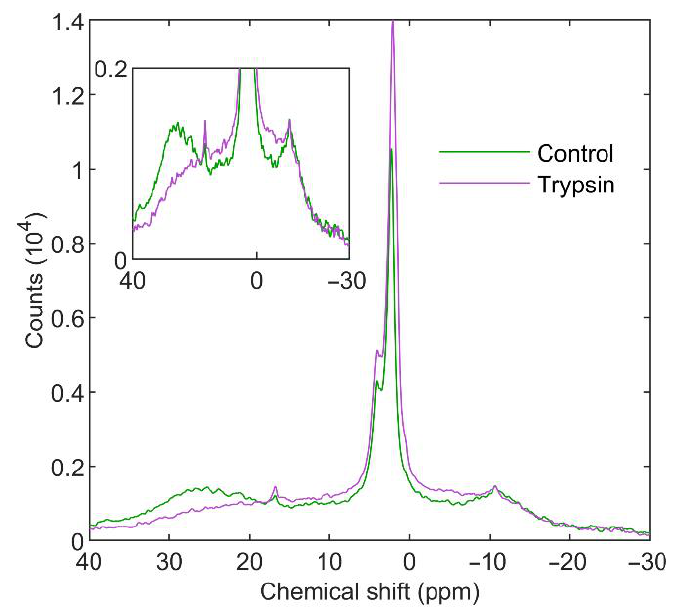
Figure 8. 31 P-NMR spectra of isolated spinach thylakoid membranes untreated (green) and treated with 10 mg mL − 1 Trypsin (purple) for 2 h. Two spectra from independent experiments of control and treated samples, pairwise displaying similar features, were averaged; temperature, 5 ◦ C. Inset highlights the L and H II regions. Spectra were normalized to total Chl contents of 10 mg mL − 1 and acquisition times of 75 min.